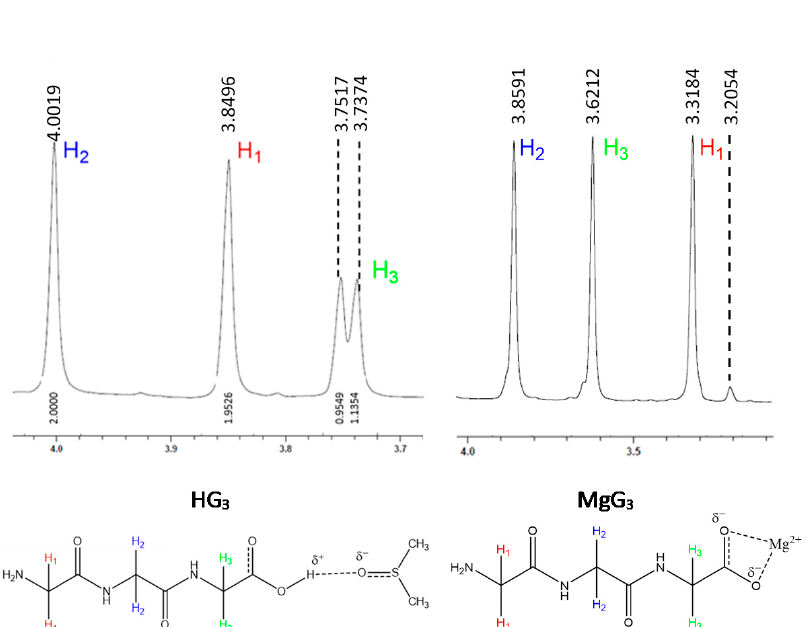
Figure 3. 1 H-NMR of HG 3 in DMSO-d 6 ( A ) showing an observable split (J = 5.7 Hz) of the carboxylic acid proton due to participation in hydrogen bonding, and the 1 H-NMR of MgG 3 ( B ) no longer showing the observable split of the carboxylic acid proton, suggesting that the ligand has coordinated to the magnesium through the carboxylic acid. Full spectra available in Supplementary Figure S9.